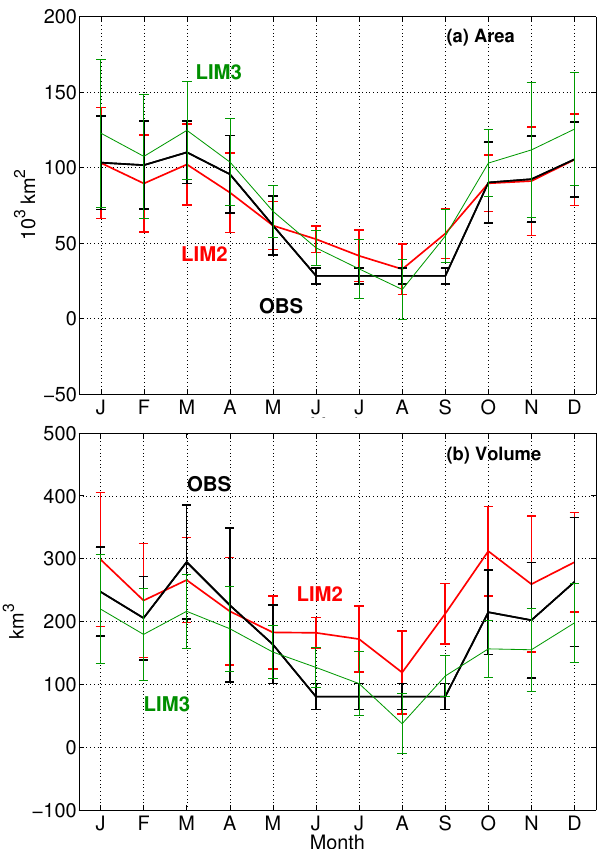
Fig. 5. Simulated and observed (Kwok et al., 2004; Spreen et al., 2009) monthly mean sea ice area (a) and volume (b) exported through Fram Strait, over the 1983–2007 period. Positive values indicate southward fluxes. The error bars represent ± 1 σ deviation of the monthly exports during the same